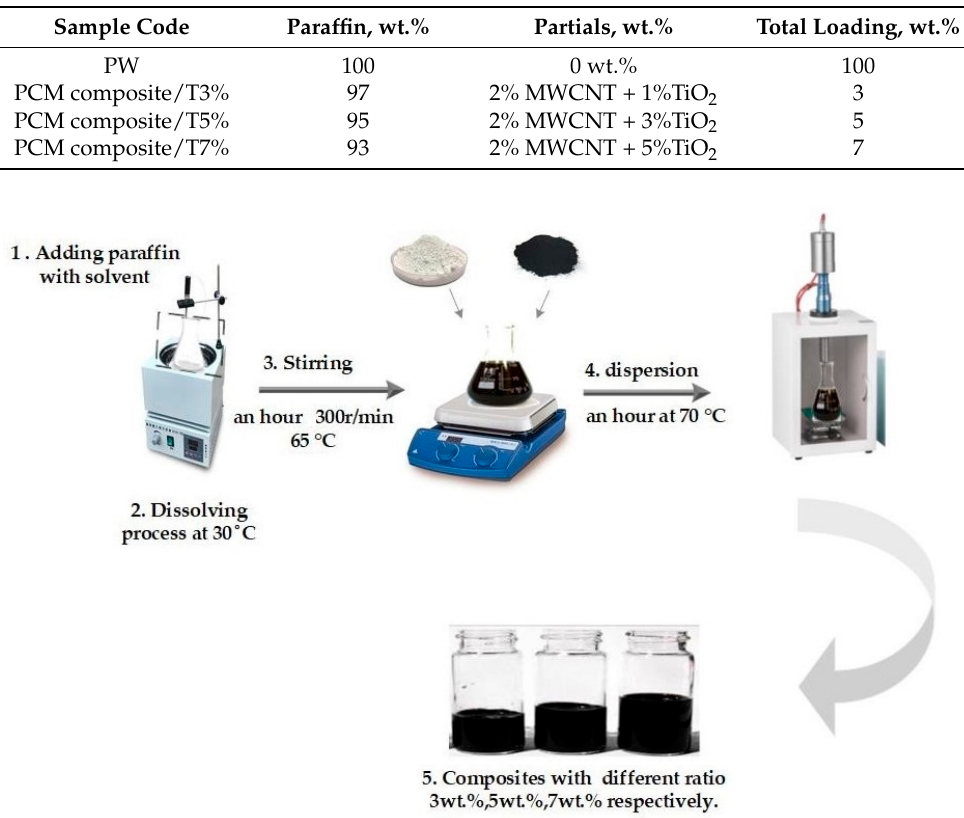
Figure 1. Schematic representation of the preparation methods of the composites with ratio loading nanoparticles (3 wt., 5 wt., and 7 nanoparticles (3 wt., 5 wt., and 7 wt.%).